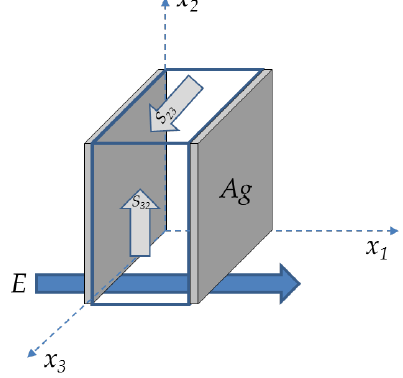
Figure 1. Piezoelectric shear strains S 23 and S 32 induced on the x 2 and x 3 faces of a paratellurite crystal by applying electric field E between the x 1 faces using silver (Ag) electrodes.